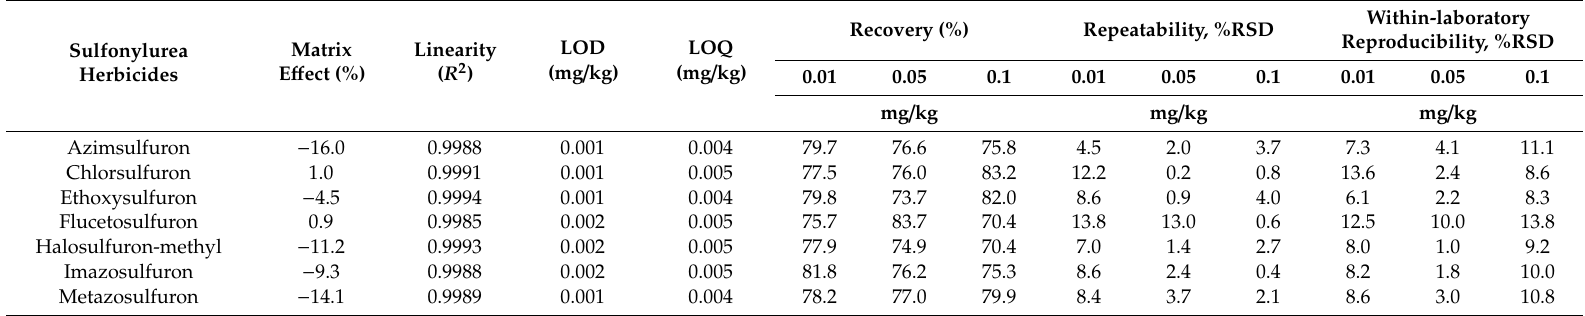
Table 2. Matrix-e ff ect and method-validation data for selected sulfonylurea herbicides in strawberries using the d-SLE method with LC-MS /